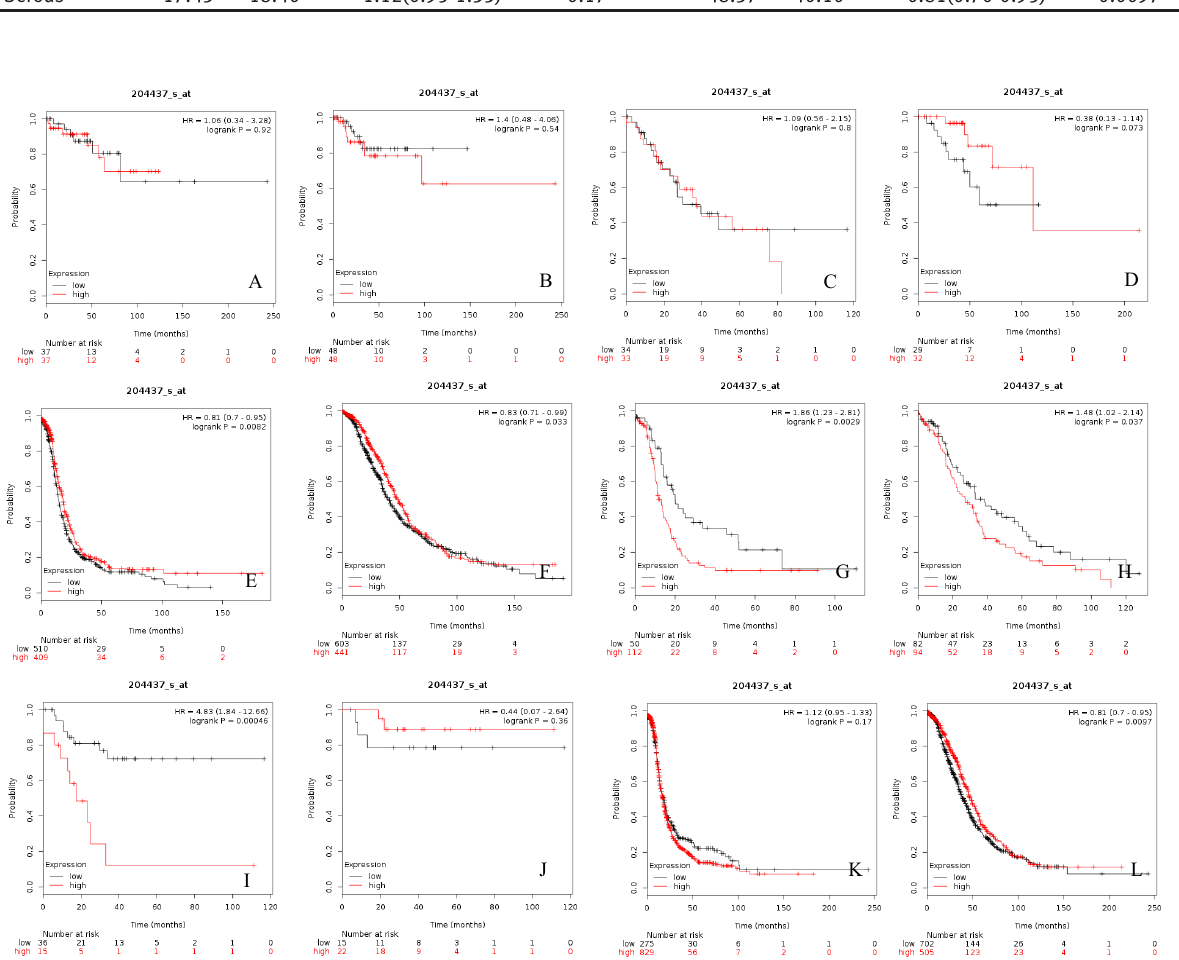
Figure 5: Subgroup survival analysis for FOLR1 gene expression survival curves according to clinical stage and histology (A: OS of stage 1 ovarian cancer; B: PFS of stage 1 ovarian cancer; C: PFS of stage 2 ovarian cancer; D: OS of stage 2 ovarian cancer; E: PFS of stage 3 ovarian cancer; F: OS of stage 3 ovarian cancer; G: PFS of stage 4 ovarian cancer; H: OS of stage 4 ovarian cancer; I: DFS of endometrioid ovarian cancer; J: OS of endometrioid ovarian cancer; K:DFS of serous ovarian cancer; L: OS of serous ovarian